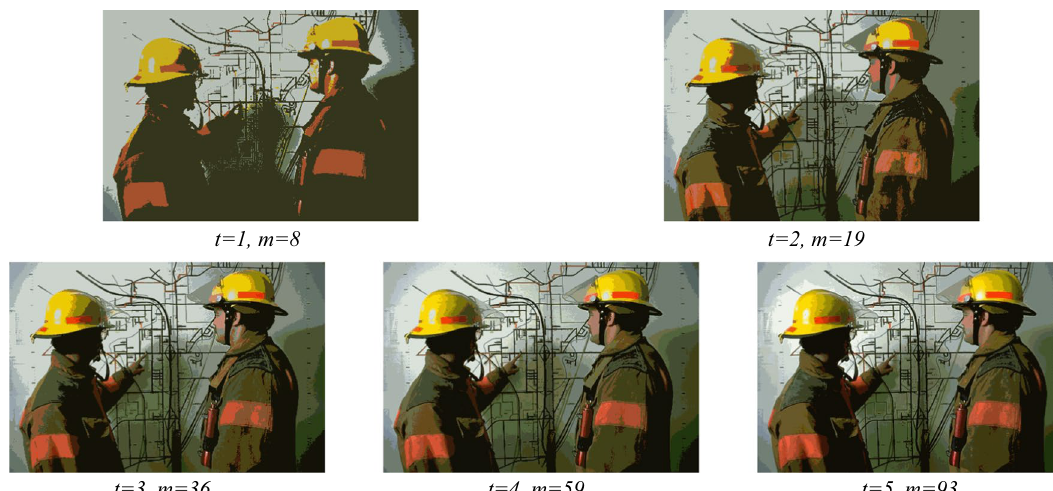
Fig. 11 Quantized 23084 image using